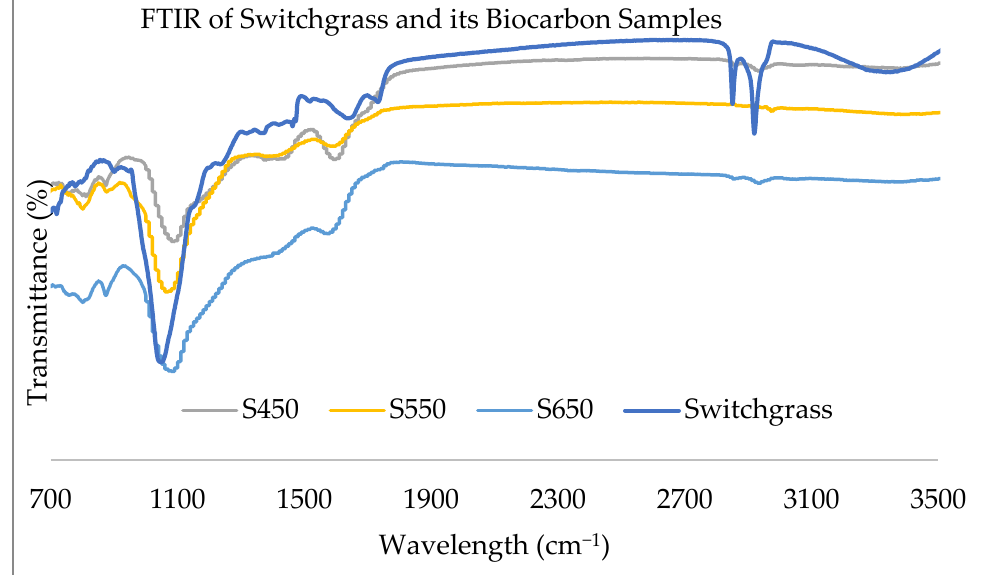
Figure 3. FTIR of the switchgrass and its biocarbon at different pyrolysis temperatures.